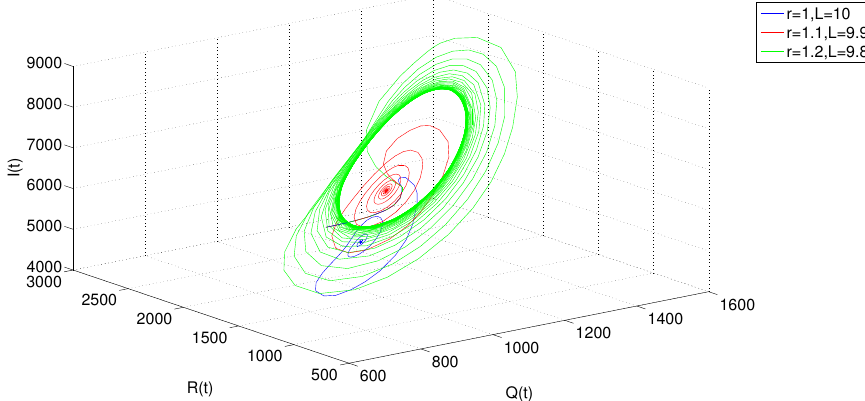
Figure 9. Dynamic behavior of system (22): projection on I-Q-R for different ϕ and ε at τ = 9.25.